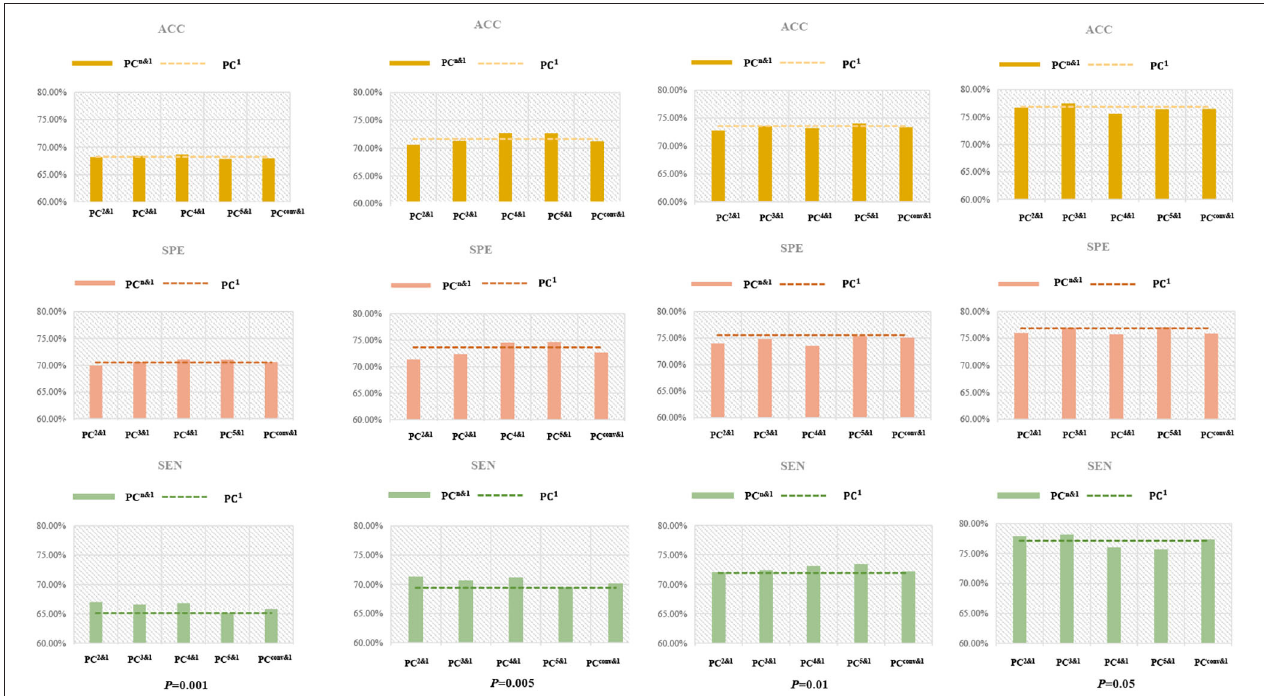
FIGURE 9 | The performance (ACC, SPE, and SEN) for MCI identification based on fusion of PC n -based BFN and PC 1 -based BFN under different p -values. The PC n & 1 corresponds to the fused performance of PC n and PC 1 , n = 2,3,4, conv. The dotted line is the performance of PC 1 itself (without fusion with PC n ). We can observe that the fusion of low- and higher-order BFNs fails to improve the ACC and SPE in most cases, but generally improves